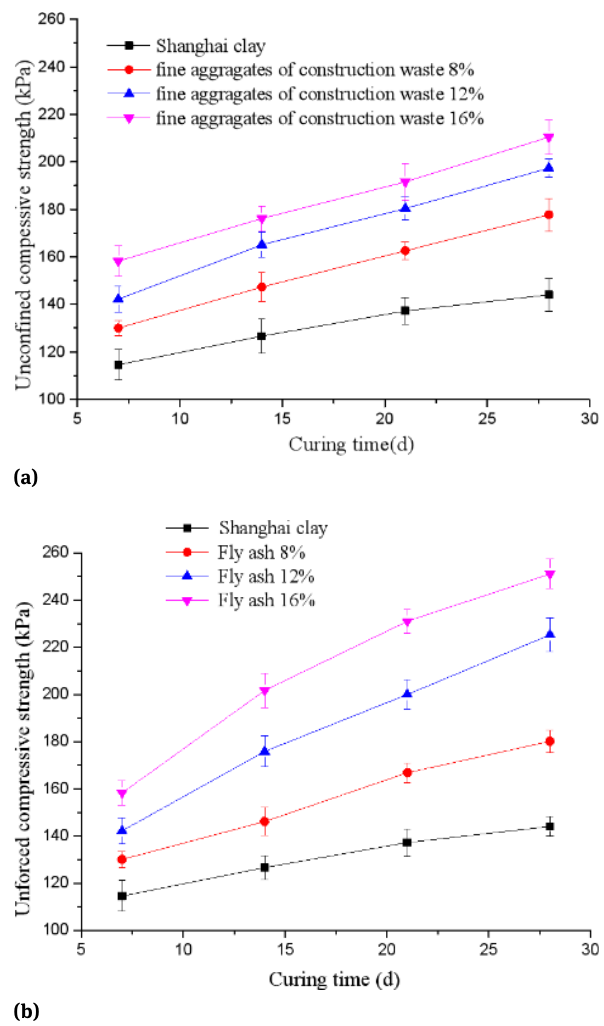
Figure 8: Effect of curing period on unconfined compressive strength of fine aggregates of construction waste (a) and fly ash